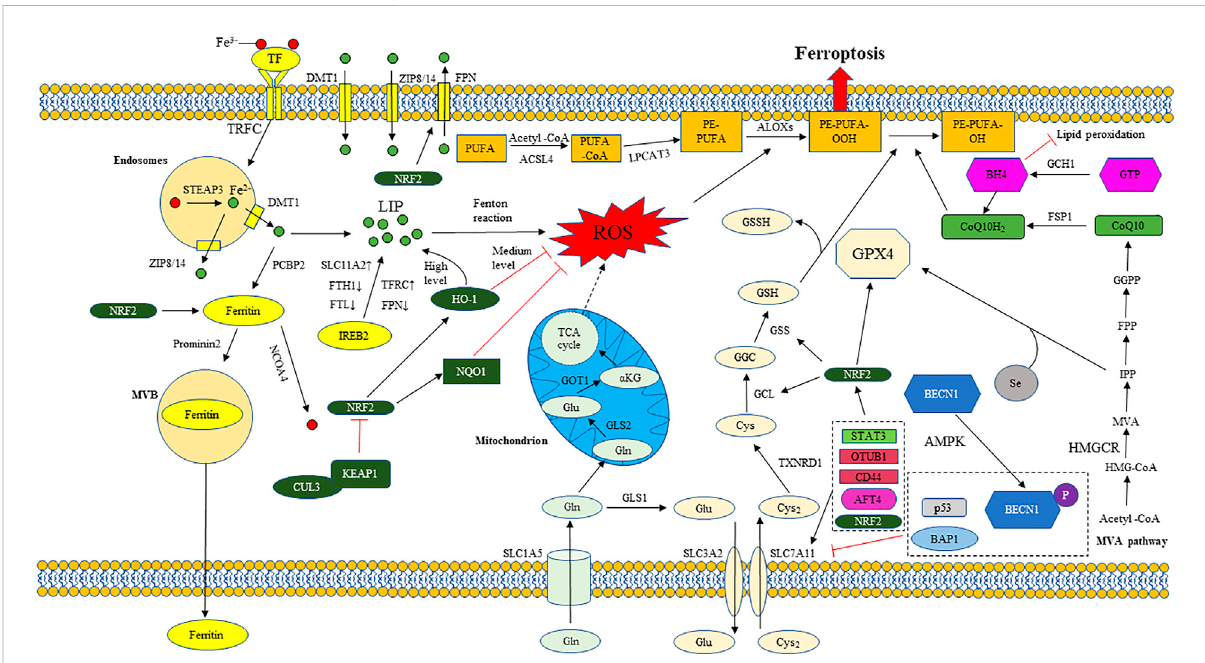
FIGURE 1 The regulatory mechanism of ferroptosis. The regulatory network of ferroptosis is mainly divided into two categories: Oxidation system and antioxidant system. The oxidation system includes iron metabolism, lipid metabolism, glutamate metabolism, etc. The antioxidant system includes system xc − /GSH/GPX4 axis, FSP1/CoQ10/NAD (P) H axis, GCH1/BH4 axis, etc. Iron metabolism: Transferrin (TF); Transferrin receptor 1 (TFRC); Six transmembrane epithelial antigen of protein 3 (STEAP3); Divalent metal ion transporter 1 (DMT1); Zinc transporter 8/14 (ZIP8/14); Labile iron pool (LIP); ferroportin (FPN); Ferritin heavy chain 1 (FTH1); Ferritin light chain (FTL); Solute carrier family member 11A2 (SLC11A2); Iron response element binding protein 2 (IREB2); Reactive oxygen species (ROS); Poly (RC) binding protein 2 (PCBP2); Nuclear receptor coactivator 4 (NCOA4); Multivesicular bodies (MVB). Lipid metabolism: Polyunsaturated fatty acid (PUFA); Long chain acyl CoA synthetase 4 (ACSL4); Lysophosphatidylcholine acyltransferase 3 (LPCAT3); Phosphatidylethanolamine (PE); Arachidonic acid lipid peroxidase (ALOX). Glutamate metabolism: Glutamine transporter (SLC1A5); Glutamic acid cysteine ligase 1 (GCL1); Glutamic acid cysteine ligase 2 (GCL2); Glutamic-oxaloacetic transaminase 1 (GOT1); α - Ketoglutarate ( α KG). Tricarboxylic acid cycle (TCA cycle). System xc - /GSH/GPX4 axis: Cystine/glutamate antiporter (system xc − ); Solute carrier family member 7A11 (SLC7A11); Solute carrier family member 3A2 (SLC3A2); Glutathione (GSH); Thioredoxin reductase 1 (TXNRD1); Glutamic acid cysteine ligase (GCL); Glutathione synthetase (GSS); Glutathione peroxidase 4 (GPX4); oxidized glutathione (GSSG); Selenium (Se). FSP1/CoQ10/NAD (P) H axis: ferroptosis suppressor protein 1 (FSP1); Oxidized coenzyme Q10 (CoQ10); Reduced coenzyme Q10